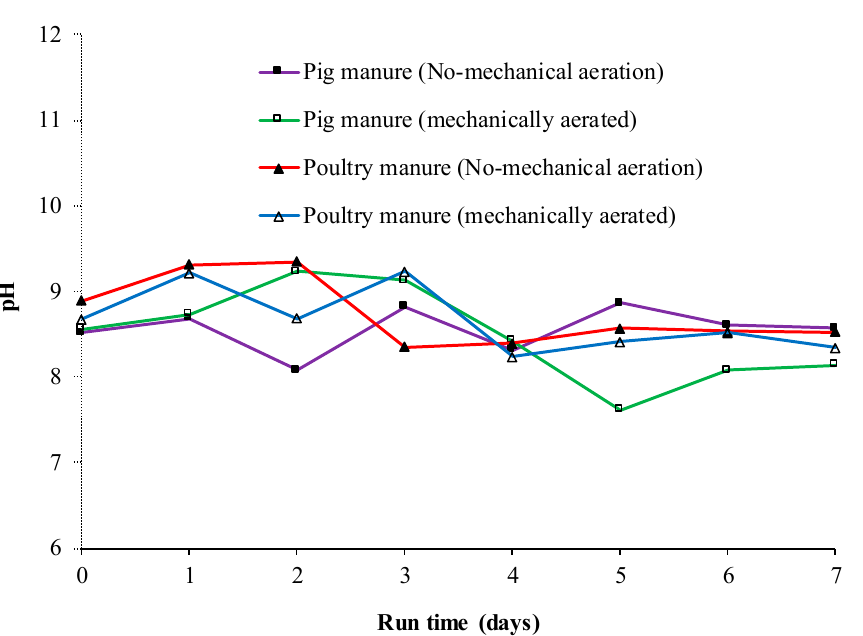
Figure 3. Changes of pH during composting of poultry and pig (swine) manure with or without mechanical aeration.